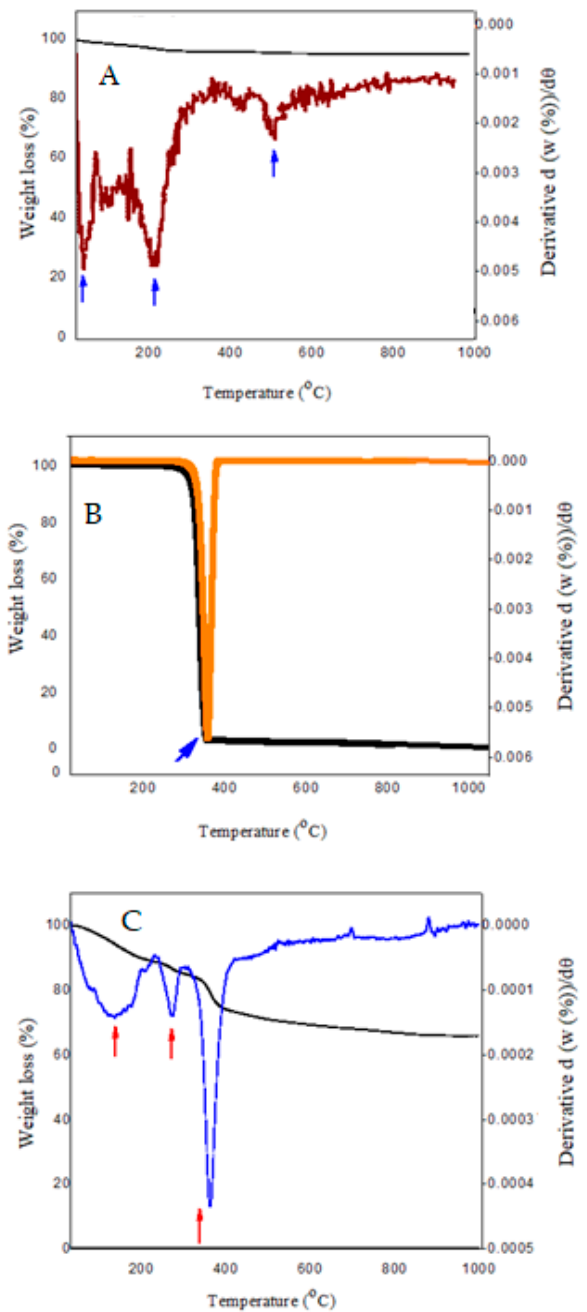
Figure 4. TGA/DTG thermograms of ( A ) pure Fe 3 O 4 ; ( B ) net PEG; and ( C ) Fe 3 O 4 @-PEG_SFB. Note: Red and blue arrows represent the sharp peaks explained in the text.